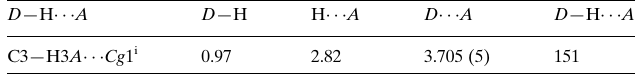
Hydrogen-bond geometry (A˚ , (cid:5) ). Cg 1 is the centroid of the C21–C26